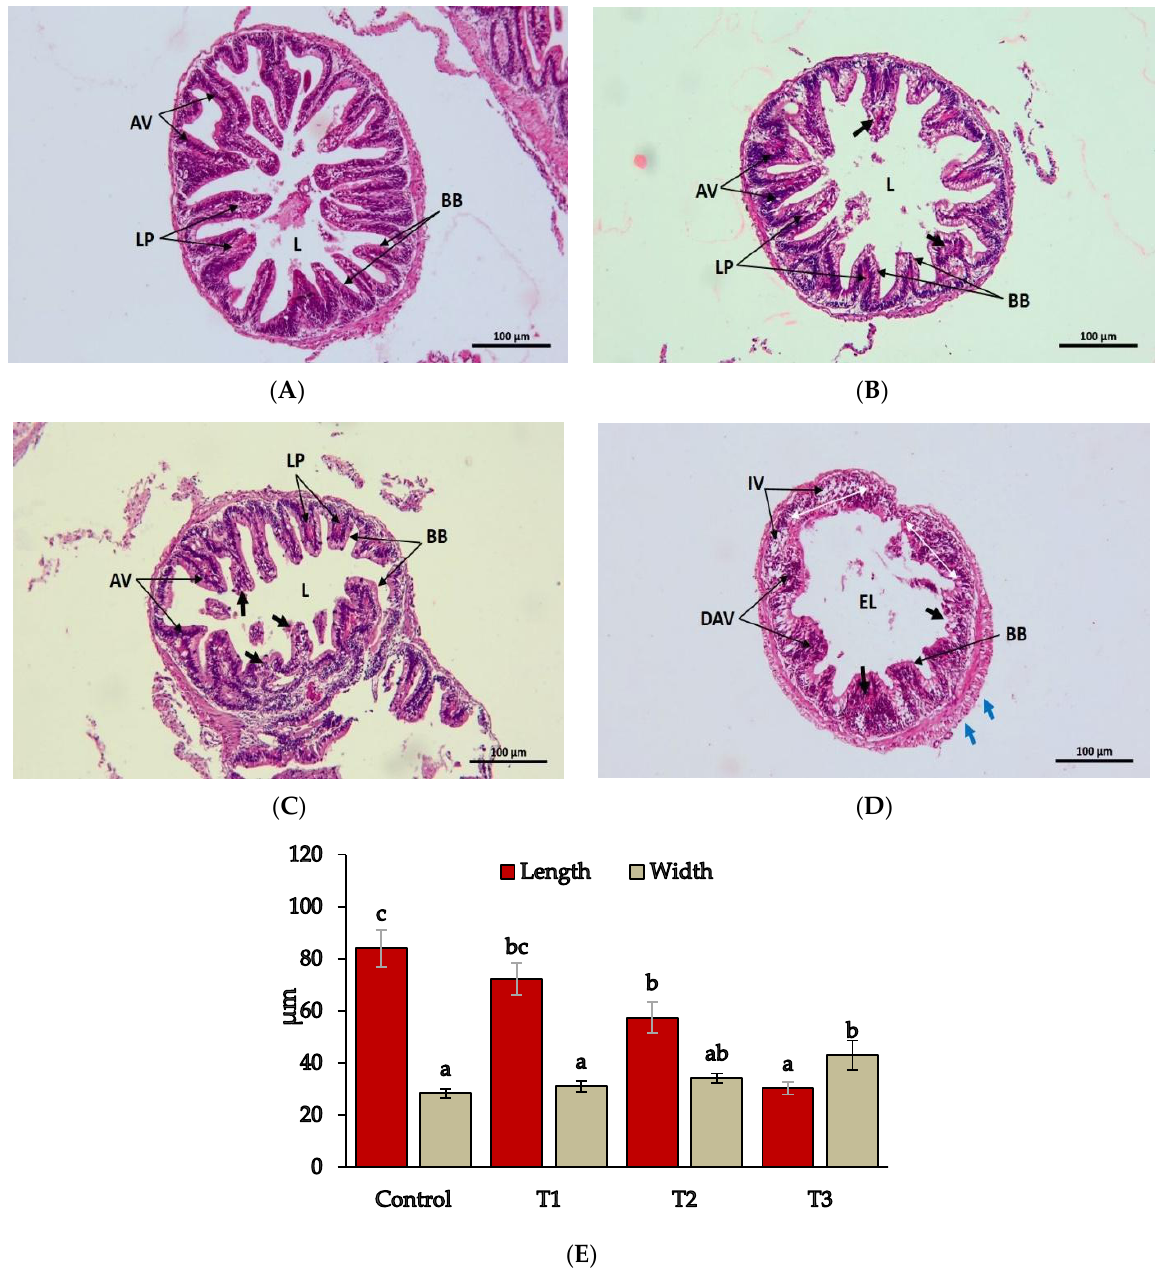
Figure 7. Transverse photomicrographs of the intestine. ( A ) Control, ( B ) T 1 , ( C ) T 2 , ( D ) T 3 . (BB — brush border, AV — absorptive vacuole, LP — lamina propria, L — lumen, EL — extended lumen, IV — increased vacuoles, DAV — disarranged absorptive vacuole; black arrows — tissue rapture, blue arrows — extended serosa, white both side arrows — wider villi); ( E ) Length and width of intestinal villi in different treatment groups. Different superscripts indicate significant differences at p < 0.05.